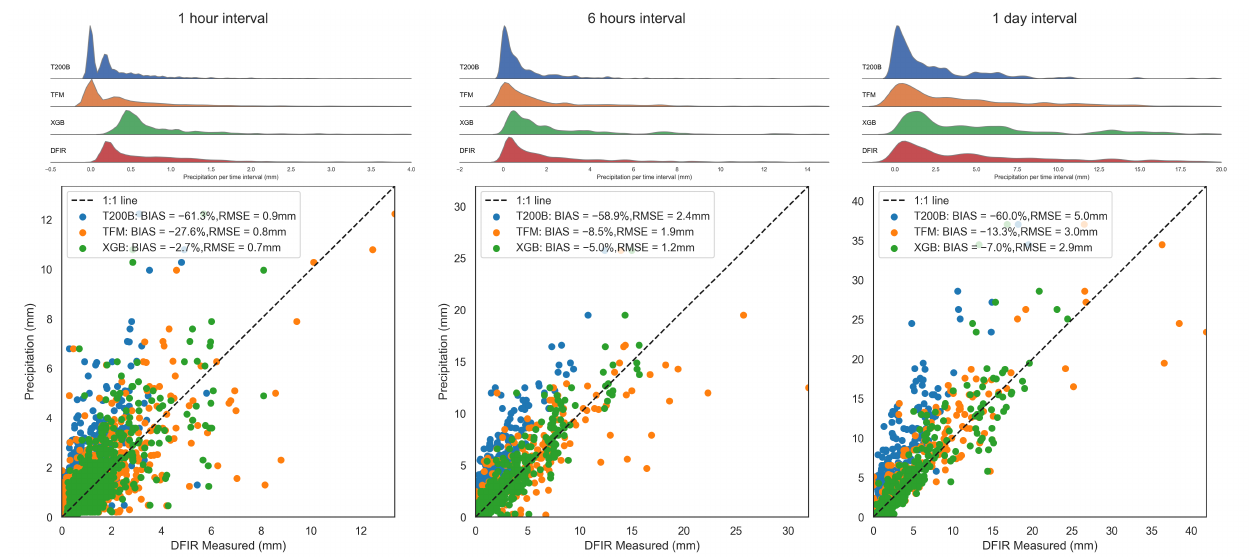
Figure 8. The corrected precipitation results are presented in three separate columns for 1 h, 6 h, and 1 d intervals. Each column represents the total precipitation during the respective time step. The XGBoost-corrected results (XGB), traditional transfer function method-corrected results (TFM), and the uncorrected T200B observation ( Y -axis) are compared with the DFIR observation ( X -axis). The comparisons include scatter plots and frequency distributions. A distinct color represents each correction method. For example, the XGBoost method is in green. The accuracy of each method is listed in the scatter plots. Only data from the validation period are used